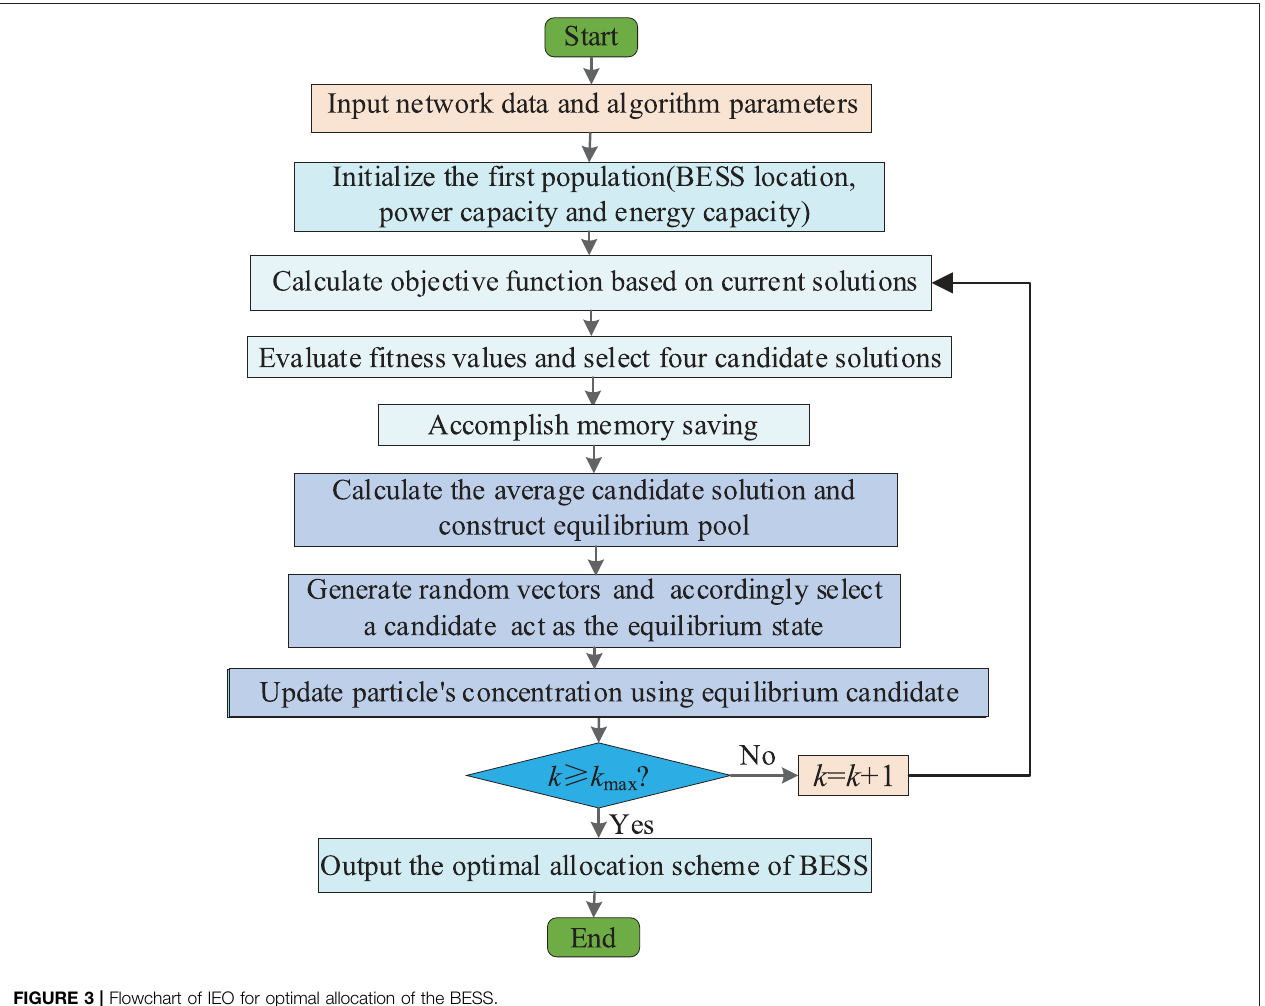
FIGURE 3 | Flowchart of IEO for optimal allocation of the BESS.